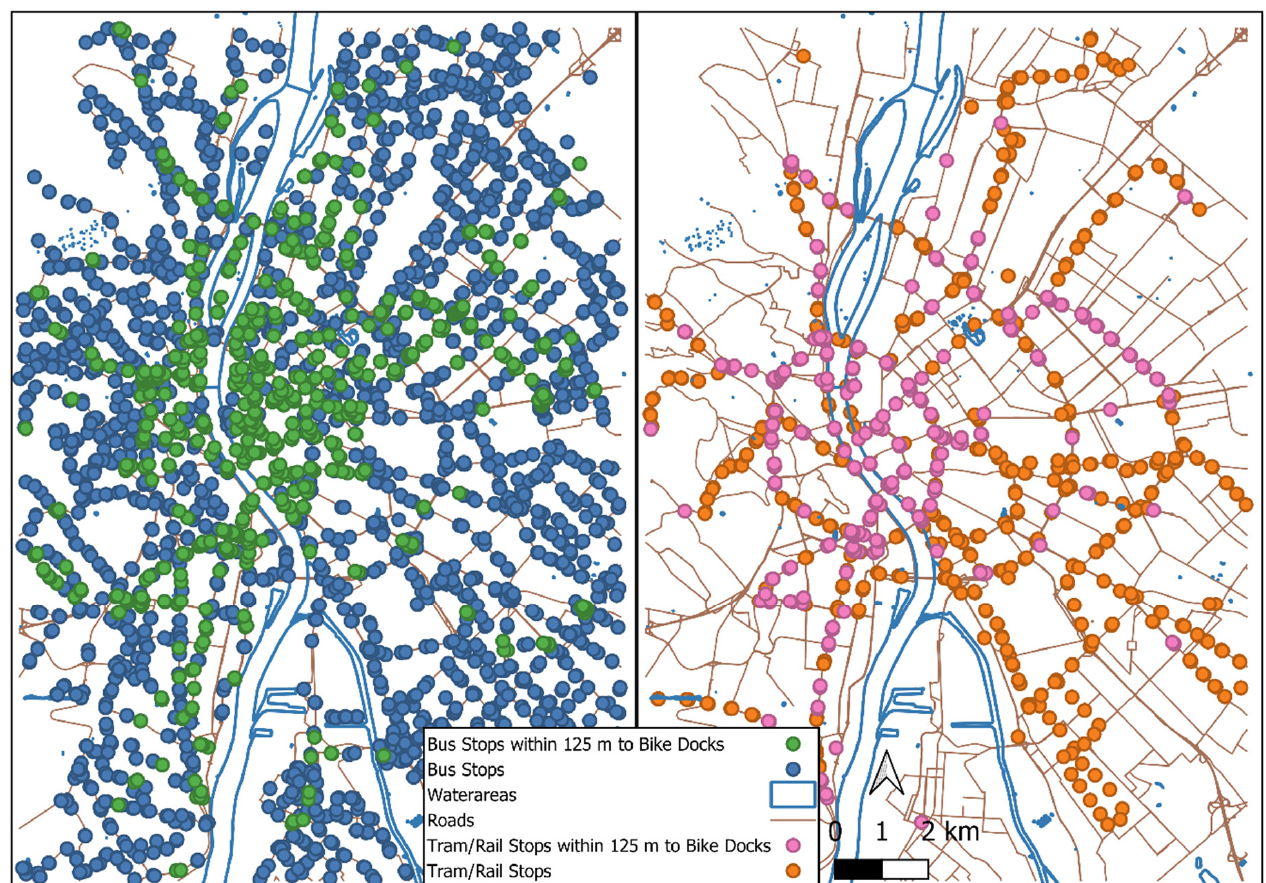
Figure 2. The Proximity of 125 m buffer between PT stops and Bike